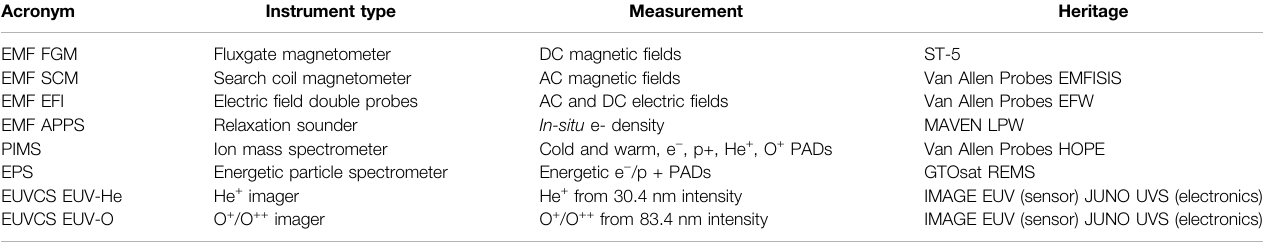
TABLE 2 | PlasmaSat instruments and heritage.